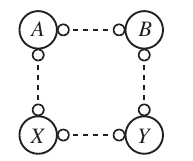
FIG. 8. Remaining class of DAGs after step 1. Dashed lines represent a connection of the type indicated or its absence.